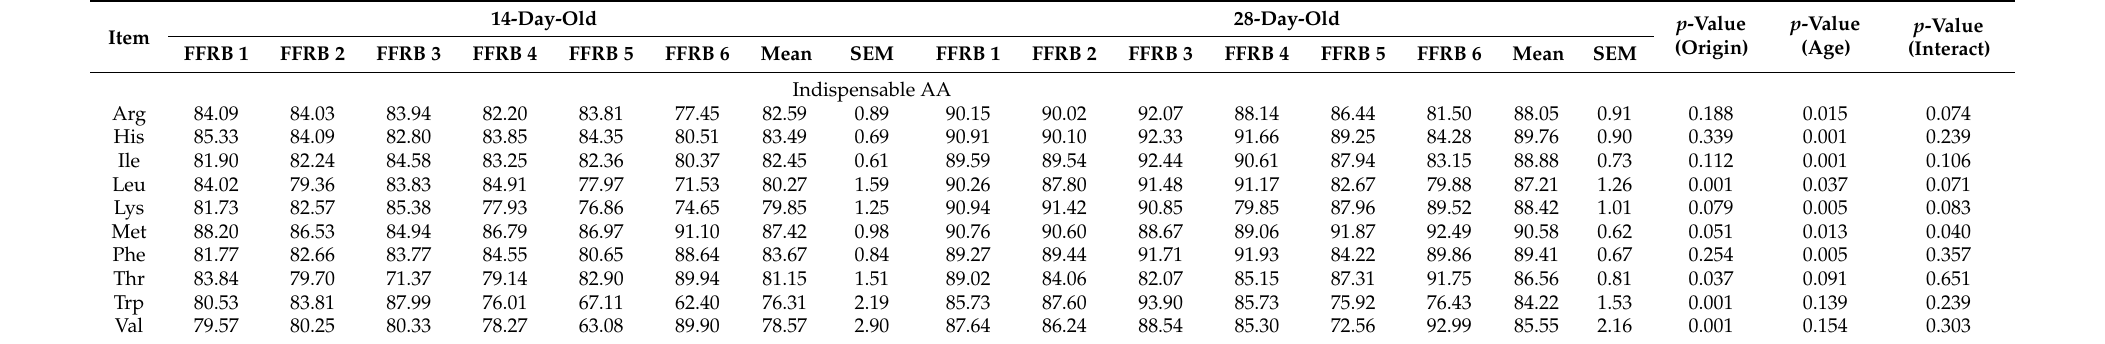
Table 9. Standardized amino acid digestibility of different sources FFRB in broilers